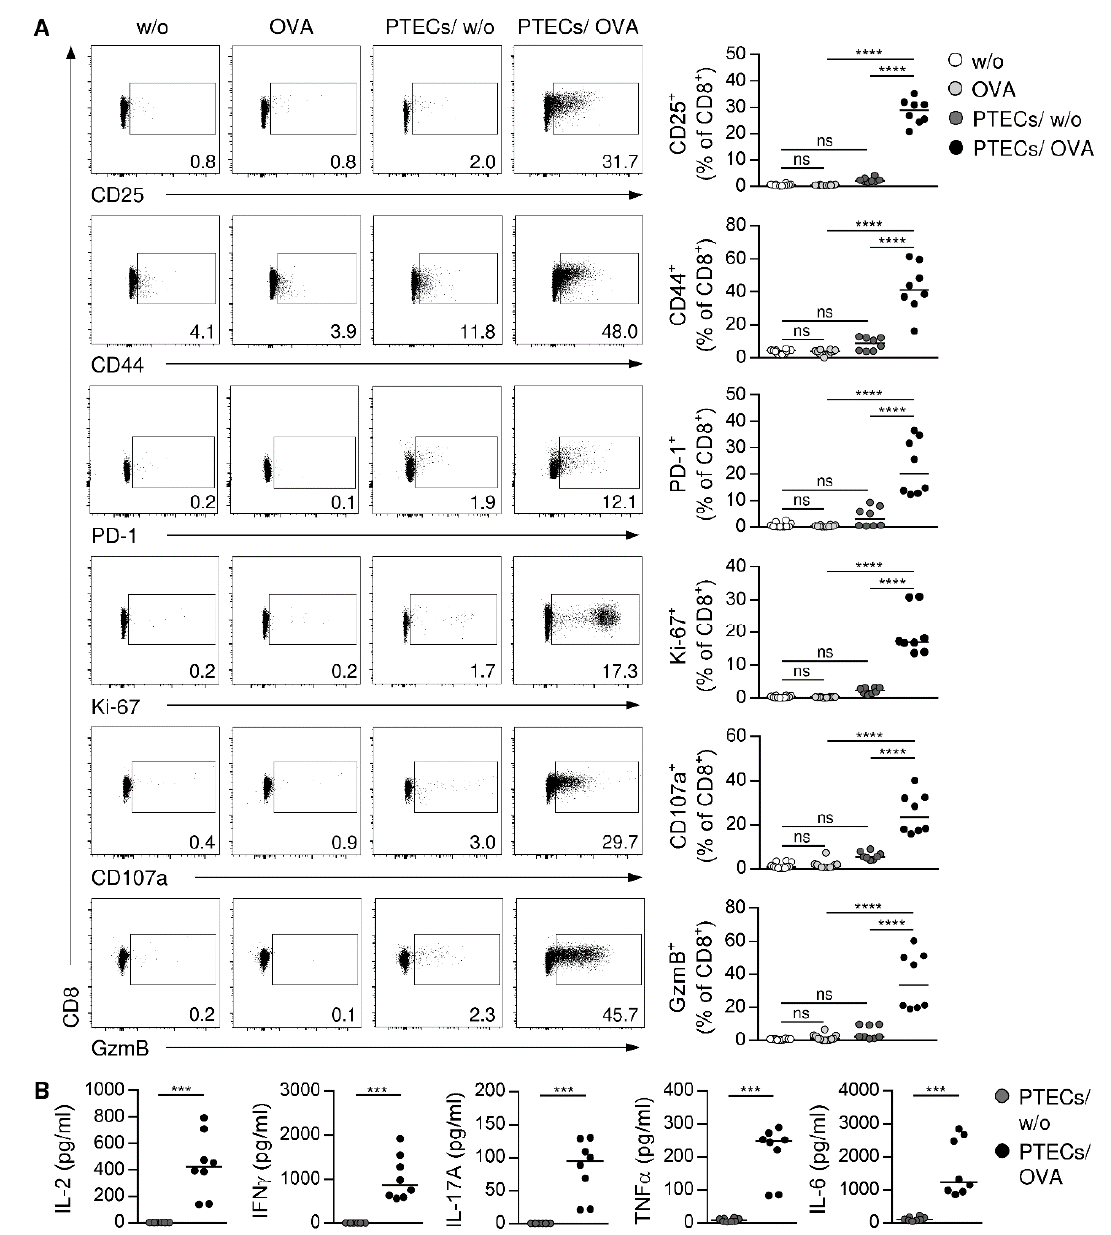
Figure 3. Antigen-dependent activation of CD8 + T cells by PTECs. OVA-specific CD8 + CD25 ‒ T cells were cultured with PTECs or alone in presence or absence of OVA for 2.5 days. ( A ) CD8 + T cells were stained for CD25, CD44, PD-1, Ki-67, CD107a, and GzmB, and analyzed by flow cytometry. ( B ) Cytokine levels were determined in culture supernatants. Representative dot plots pre-gated on CD8 + TCR β + cells and medians of 2–3 experiments are shown. *** p < 0.001; **** p < 0.0001; ns: not significant; nd: not detectable; w/o: without